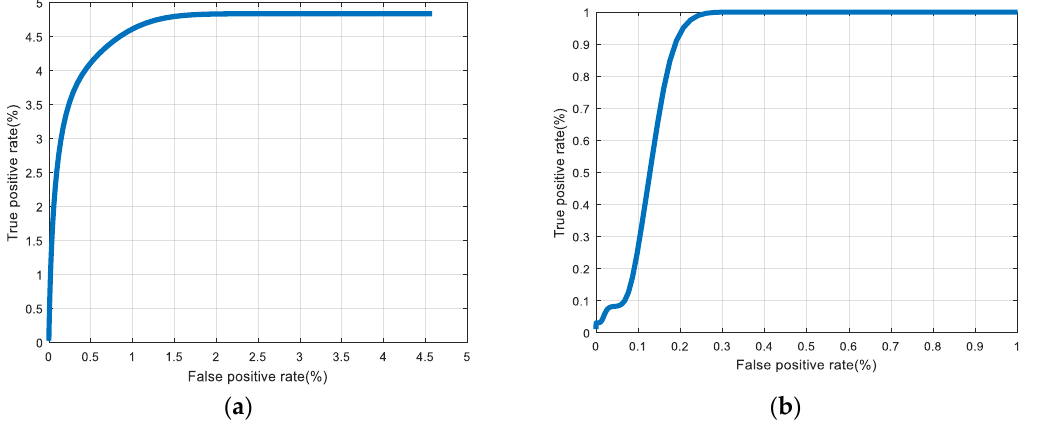
Figure 23. ROC curves in the presence of Gaussian noise in the system using an encrypted kernel with the IWT with similar keys of encryption in the presence of noise with a variance of ( a ) = 0.01, and ( b ) = 0.02.